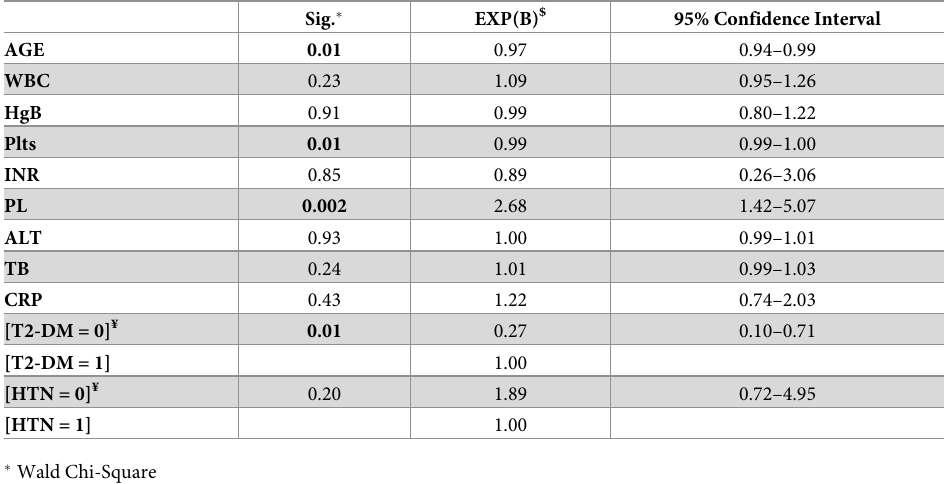
Table 6. Correlation of demographic, clinical and laboratory variables with NAS -Multivariate